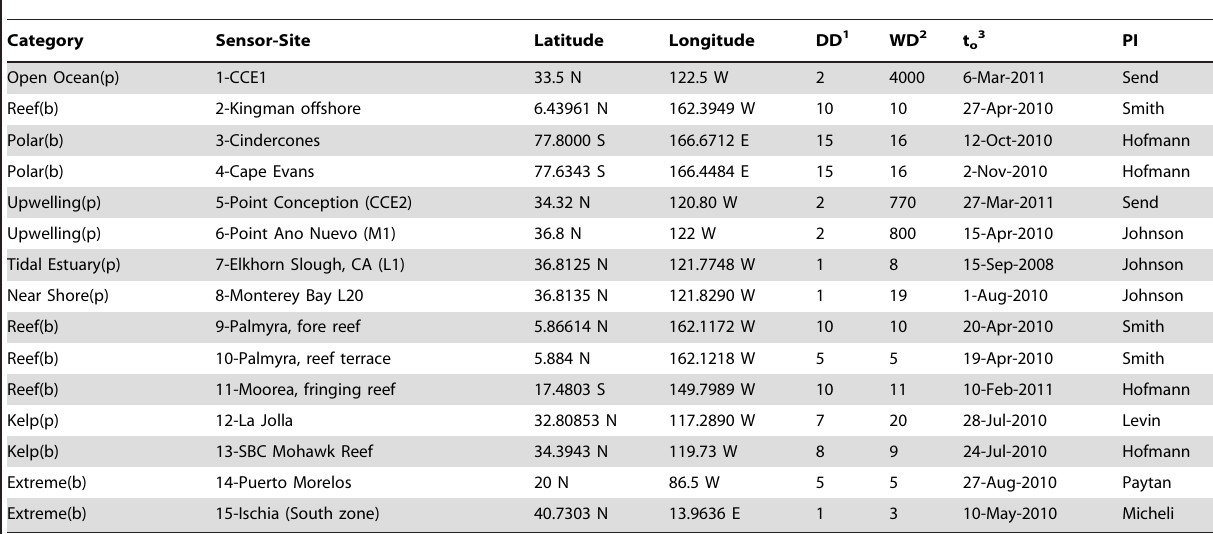
Table 1. Summary of pH sensor deployment data shown in Figure